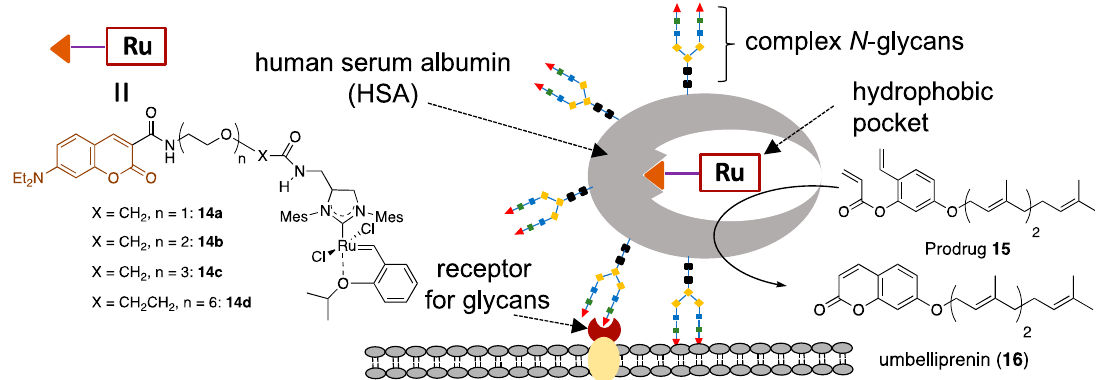
Figure 8. Hybrid OM-ArM with glycosylated human serum albumin (HSA) and ruthenium complex 14 [41,42].